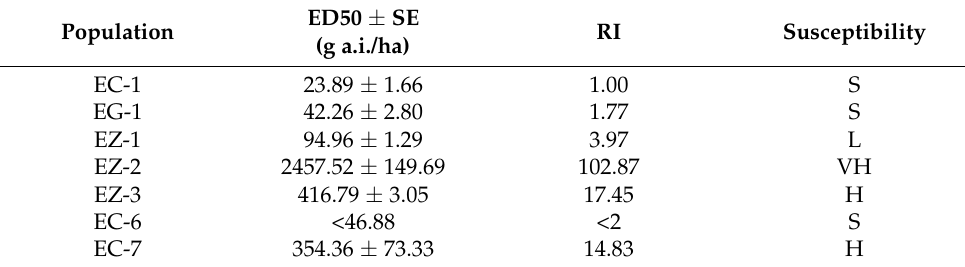
Table 6. The susceptibility of different E. spp. to quinclorac.